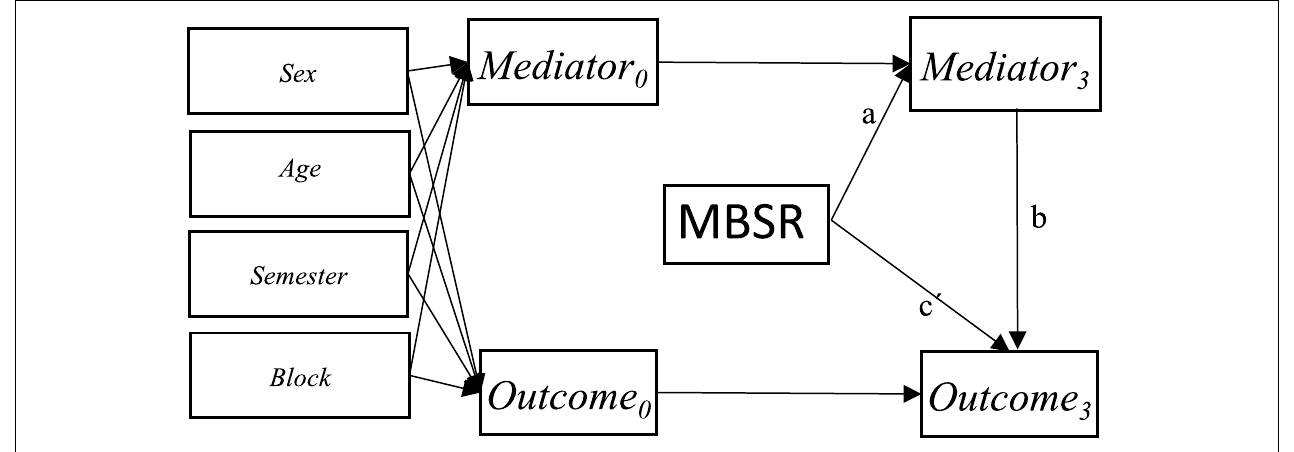
FIGURE 1 | Autoregressive mediation model showing the a, b and c’ path.